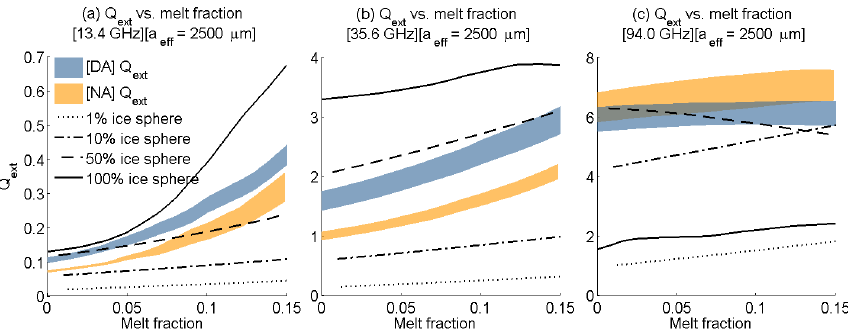
Figure 5. Same as Fig. 4 except effective radius is now 2500 microns (50-times-larger radius; 125000-times-larger mass). As before, the vertical axes are on different scales. Notice the swap at 94GHz, where the needle aggregate exhibits a higher extinction than the dendrite aggregate.